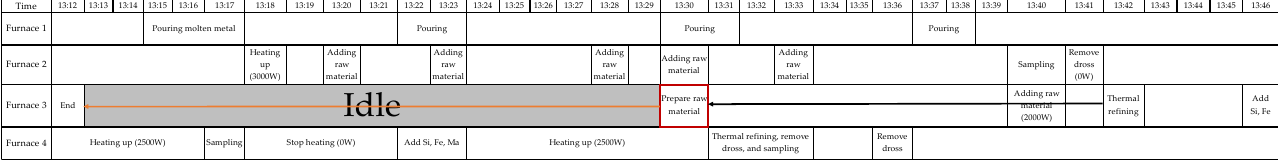
Figure 7. ANOVA: Molten-metal-making times versus 14 furnace operators. * indicates that the statistical test result is significant. The manager agreed with the above conclusion since the furnace operators have dif- ferent levels of skills. To pinpoint who is taking longer in molten-metal-making times, we proposed the Least-Significant Difference (LSD) analysis of operation times, and the result is in Table 2. In Table 2, we can divide the operators into three groups: With the letter A only, with letters A and B, and with the letter B only. Operators with both A and B led to no significant differences in molten-metal-making times. It can be observed from Table 2 that operators with only the letter A took a longer time (>81 min) than operators with the only the letter B (~60 min) to melt the raw material. In short, operator I, operator J, and